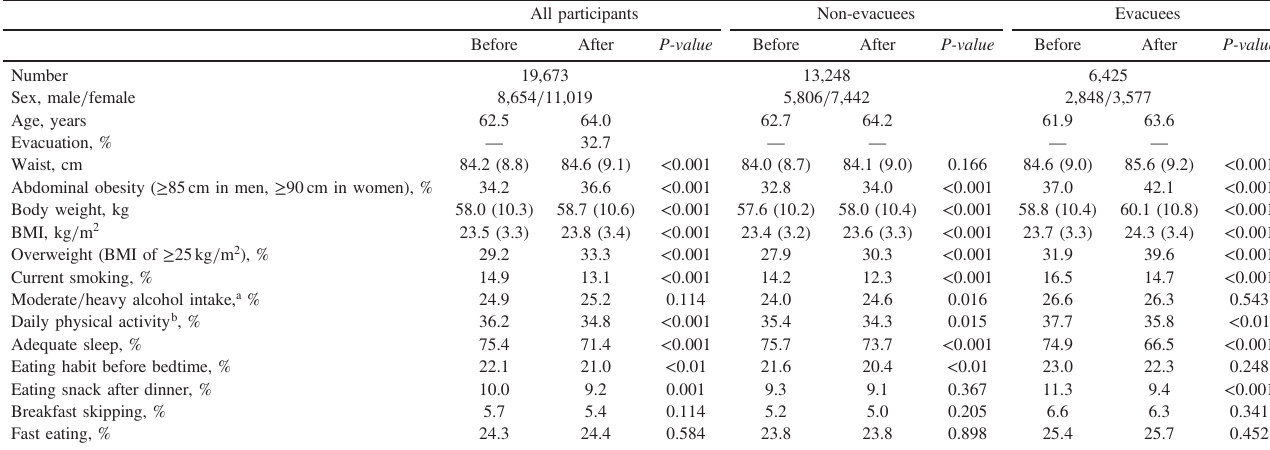
Table 1. Clinical and lifestyle characteristics of participants before and after the Great East Japan Earthquake All participants Non-evacuees Evacuees Before After P-value Before After P-value Before After P-value Number 19,673